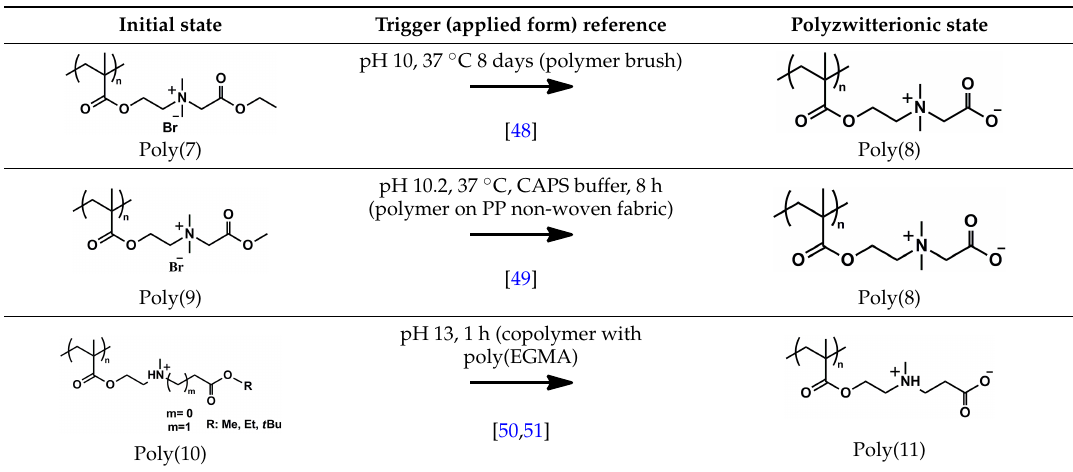
Table 1. Irreversible pH-triggered (meth)acrylic-based switches containing polyzwitterionic state.